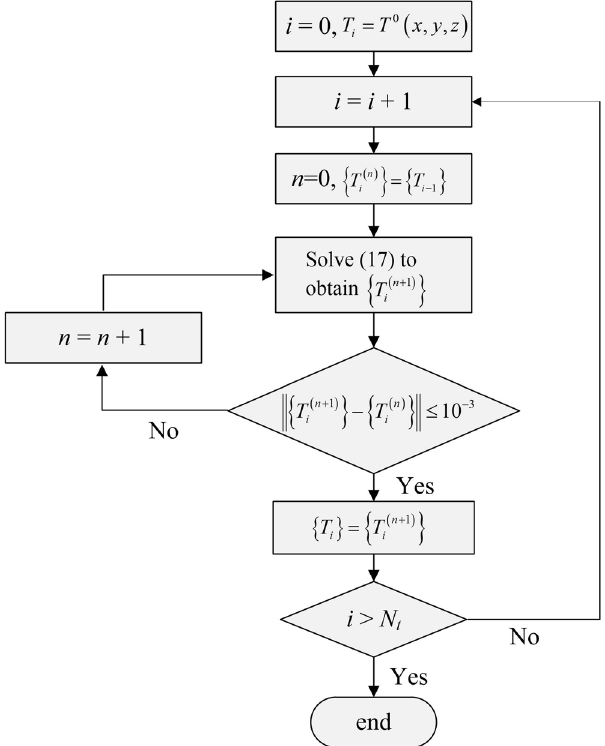
Figure 3. Flow diagram for solving the temperature distribution at each time step.